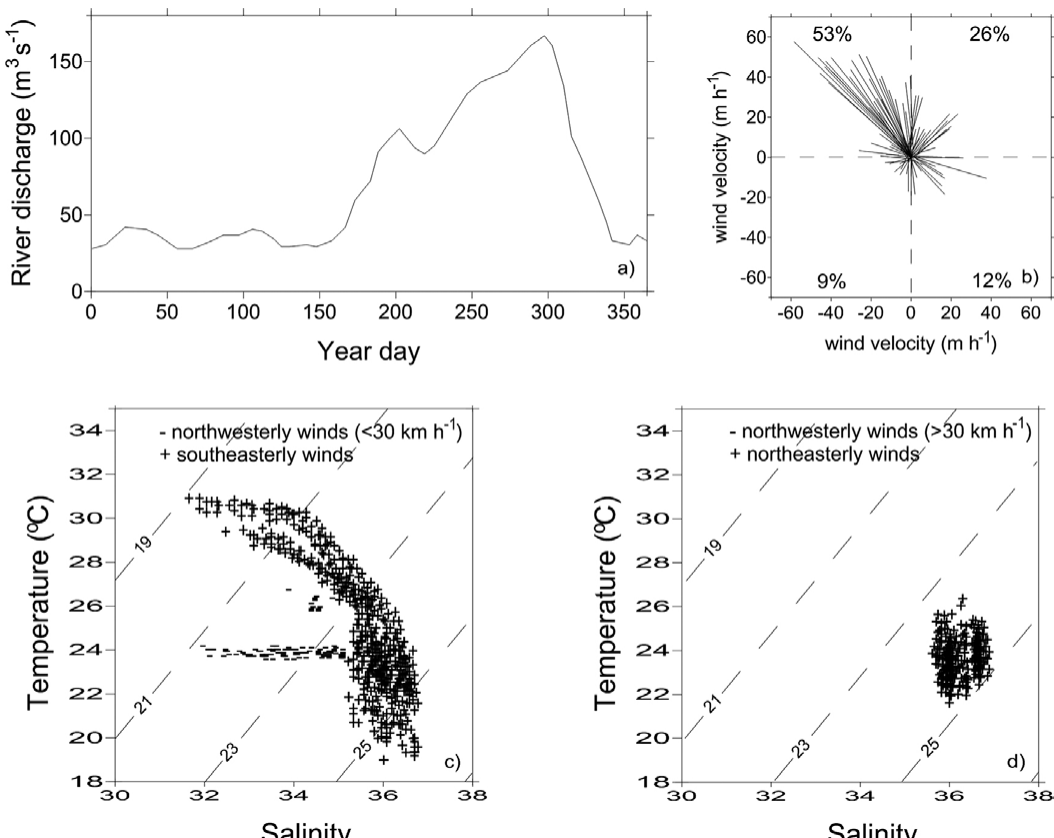
Fig. 4. – A, Jamapa River discharge; B, wind rose; C, the T-S diagram during northwesterly and southeasterly wind conditions (parallel to the isobaths); and D, strong (>30 km h –1 ) northwesterly and northeasterly wind conditions in